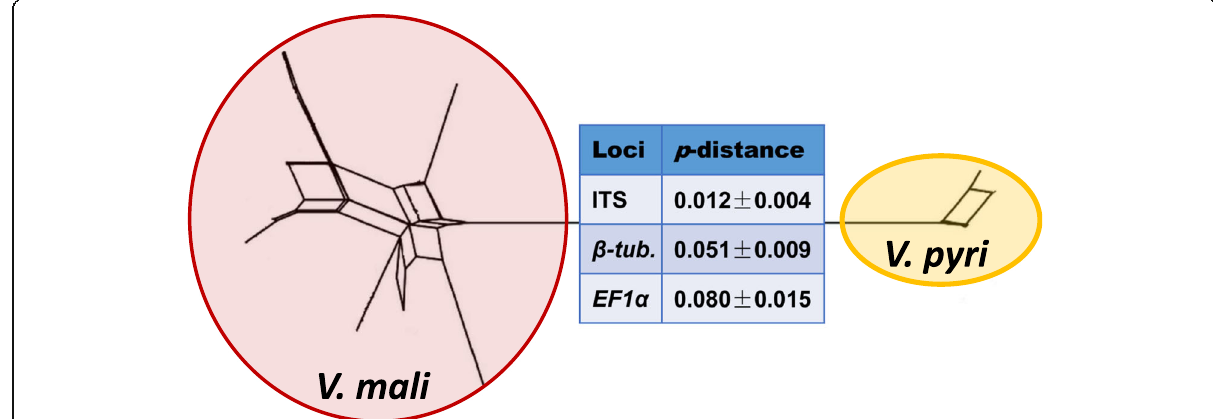
Fig. 2 Genetic divergence between Valsa mali and Valsa pyri . The phylogenetic relationship is illustrated by a network constructed from the concatenated alignments of DNA sequences for three loci: ITS, β -tubulin and EF1 α . The means and standard errors of the p-distances calculated from each locus are shown in the inserted table on the branch separating the species. This figure was modified from Wang et al.